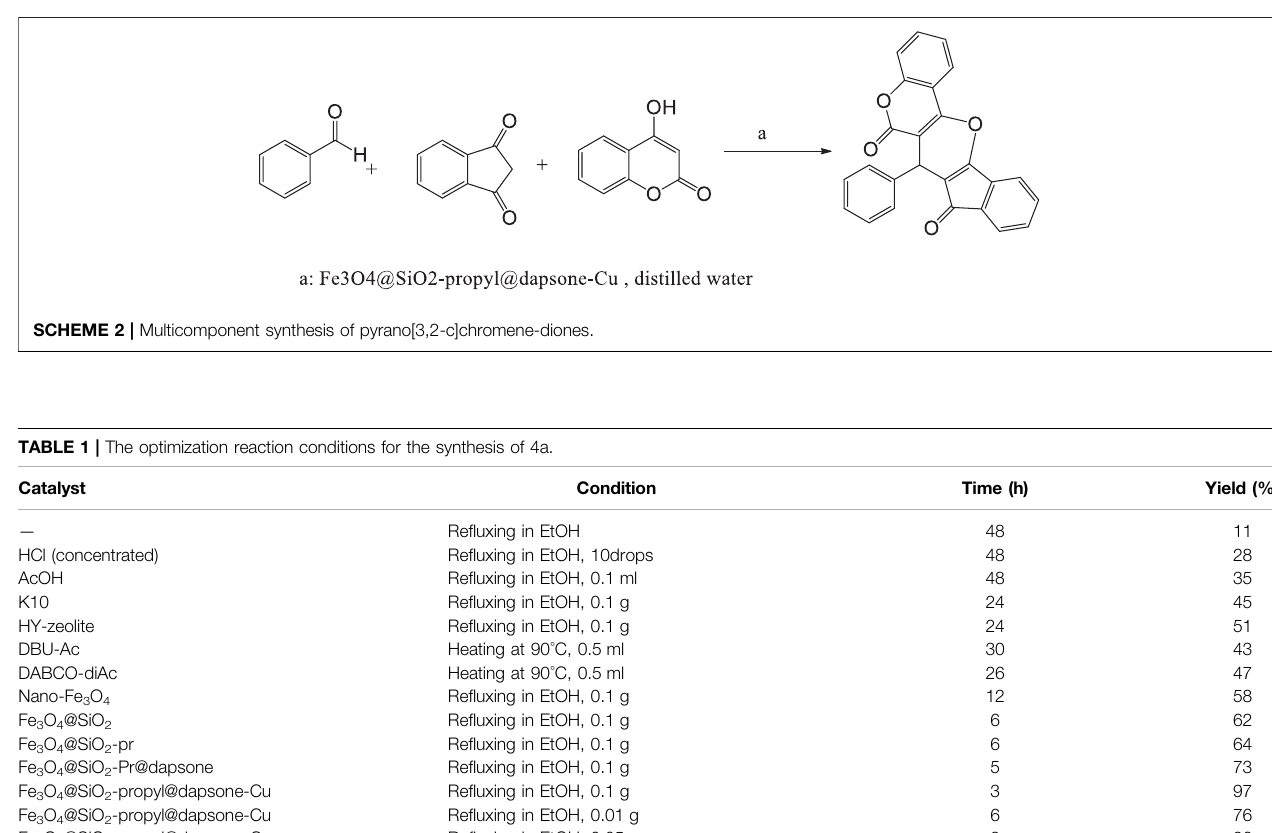
(FWHM) of the highest XRD peak (2 θ (cid:1) 35.71 o ) were obtained as 2.514 Å and 0.6888 (2 θ o ). Figure 3B revealed the TGA analysis of synthesized nanoparticles. Two weight losses are observed. The fi rst decrease is related to a temperature below 333 ° C because of desorption of water and the second weight-loss step at 524 ° C is due to decomposition of organic compound as dapsone.